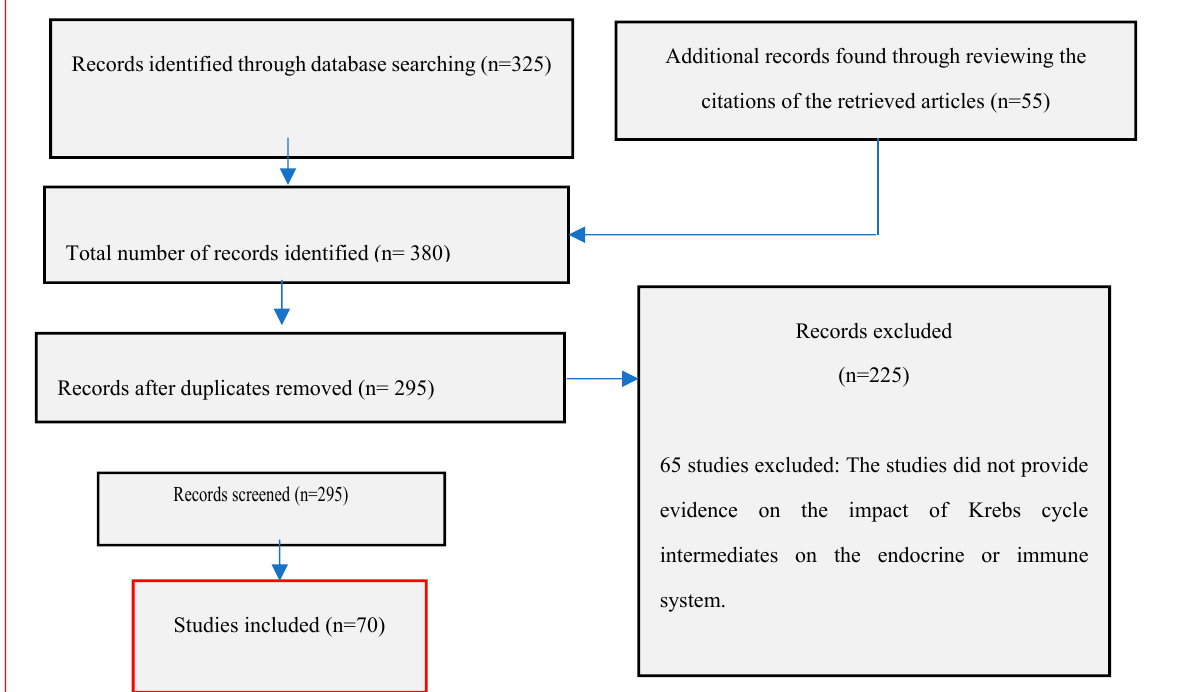
Figure 1. PRISMA flow diagram.